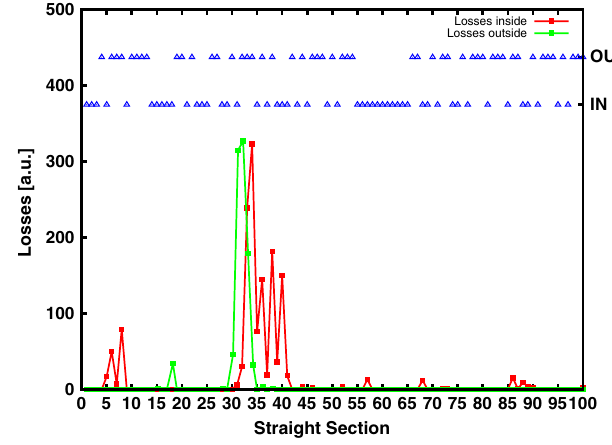
FIG. 16. Beam loss pattern simulation differentiating losses occurred inwards (red) and outwards (green) the machine. In addition, BLMs positions are displayed indicating whether they were installed inside or outside the vacuum chamber. There is a discrepancy in the BLM location and where the losses occurred in SS05-09. BLM in SS09 is located inwards the machine which explains the signal saturation due to the secondary particles produced in